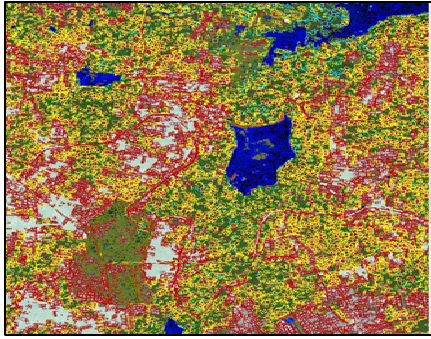
Figure ss11: KNN Classification output